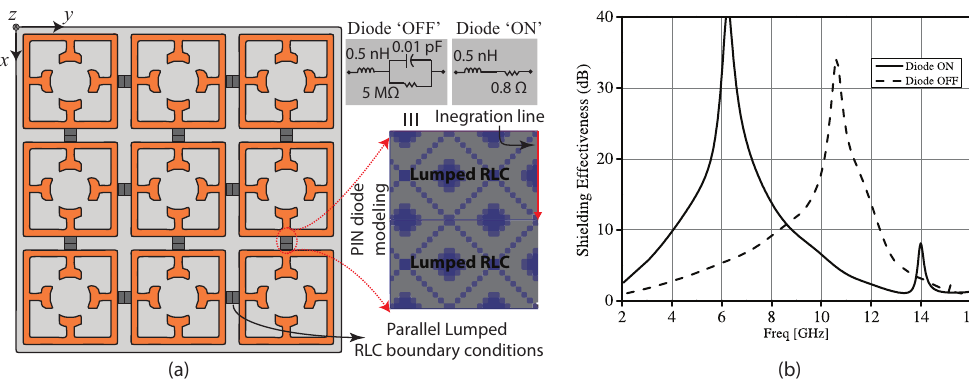
Figure 7. ( a ) Illustration of the reconfigurable variant of the proposed FSS and ( b ) the simulated SE of the proposed FSS unit cell with PIN diodes in the “OFF” and “ON” states.